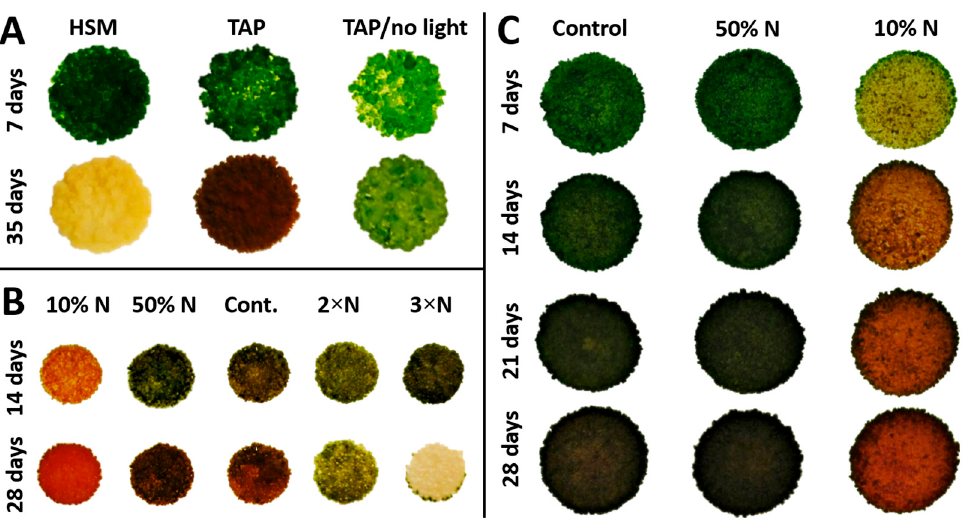
Figure 3. Growth pattern and nitrogen effect on mixotrophic growth of Chlorosarcinopsis PY02. ( A ) test for trophic pattern; ( B ) test for nitrogen effect on growth and carotenoid production by increasing nitrogen concentration (in the form of NH 4+ ) 2-fold from 7.48 mM (replete TAP medium) to 14.96 mM and 3-fold to 22.4 mM, and decreasing it 2-fold to 3.74 mM (50% N) and 10-fold to 0.748 mM (10% N); ( C ) test for effect of nitrogen reduction on carotenoid accumulation by decreasing nitrogen concentration 2-fold to 3.74 mM (50% N) and 10-fold to 0.748 mM (10% N). Abbreviation for solid media with 1.2% agar: HSM = high salt minimal; TAP = tris-acetate-phosphate; TAP/no light = TAP with no light; 10% N = TAP with 10-fold nitrogen decrease; 50% N = TAP with 2-fold nitrogen decrease; Cont. = control replete TAP nitrogen concentration; 2 × N = TAP with 2-fold nitrogen increase; 3 × N = TAP with 3-fold nitrogen increase.